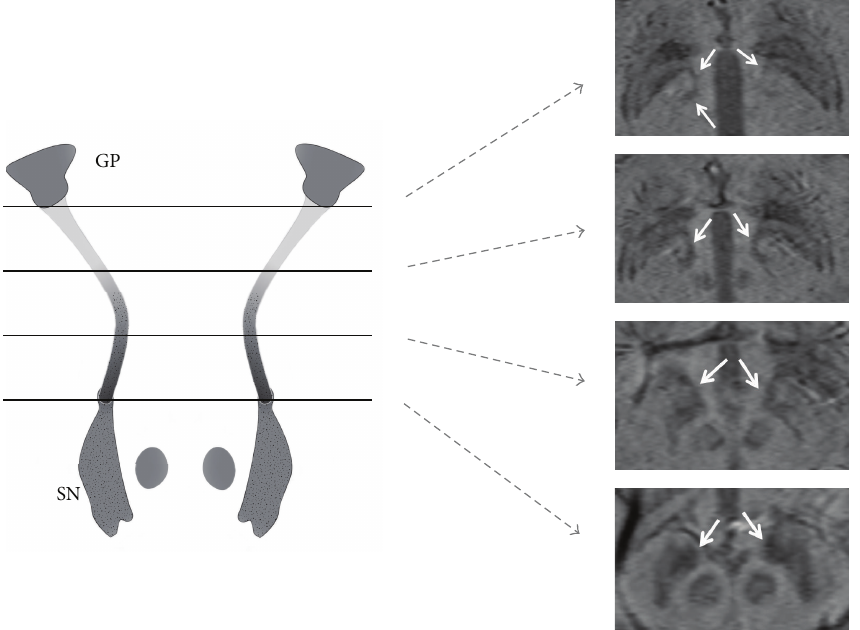
Figure 3: Illustration depicting the appearance of multiple slices through the FN (white arrows on SWI images, 2 mm thk) shown at its rostral junction with the globus pallidus descending to its caudal junction with the substantia nigra.